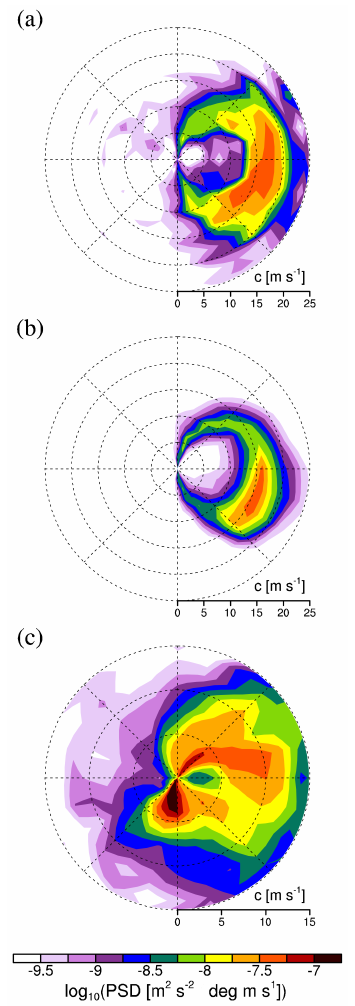
Figure 13. Power spectra of w (cid:48) at z = 1 . 5km as a function of phase speed and propagation direction calculated in (a, b) 48–73 ◦ N, 20– 60 ◦ E and (c) 21–46 ◦ N, 20–60 ◦ E. In (a) and (b) , the spectra were obtained for the wave components with horizontal wavelengths larger and smaller than 150km,